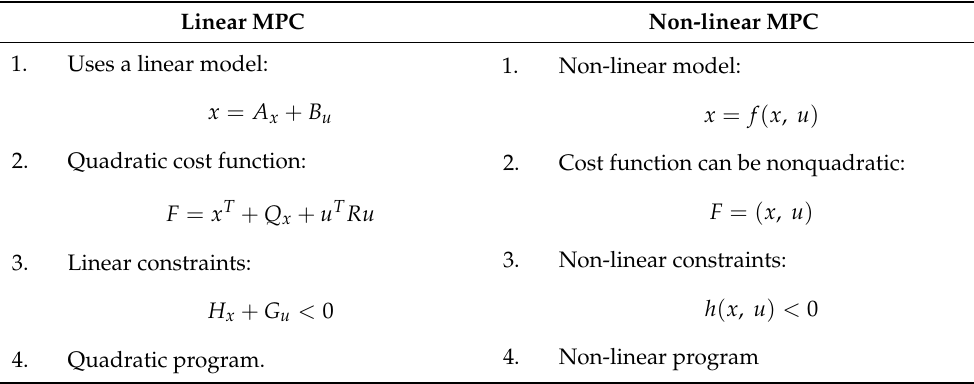
Table 2. Classification of linear and non-linear